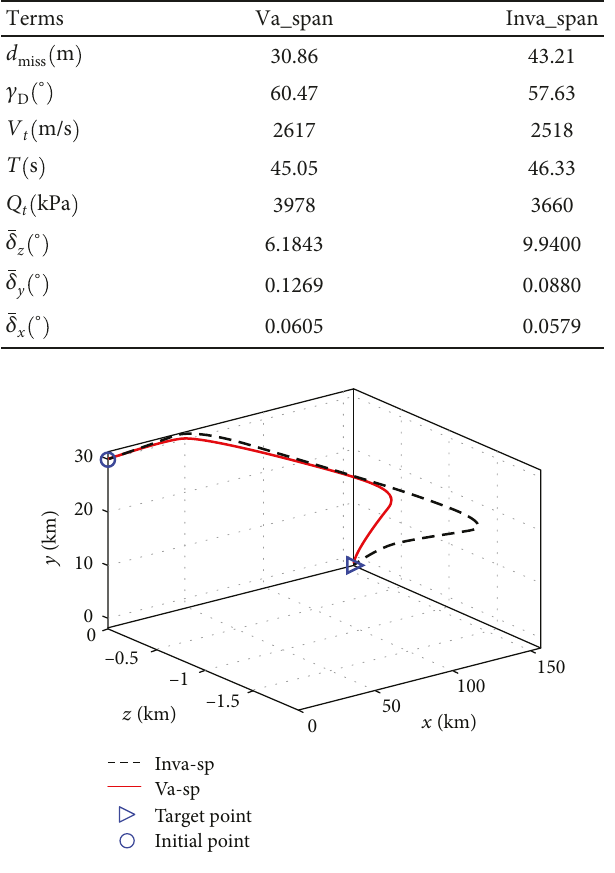
Figure 8: 3D trajectory curve in the dive phase. Inva_sp: invariable span; Va-sp: variable span.